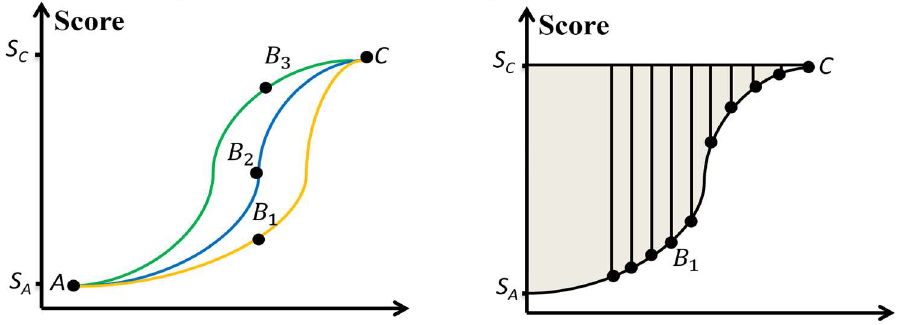
Figure 2. Illustration of peak value, reprinted from Ref. [36]. 2018, Linguang Zhang. ( Left ): different response curves can lead to same ranking. ( Right ): peak value of the response curve can be evaluated as the area above the most-peaked response curve.